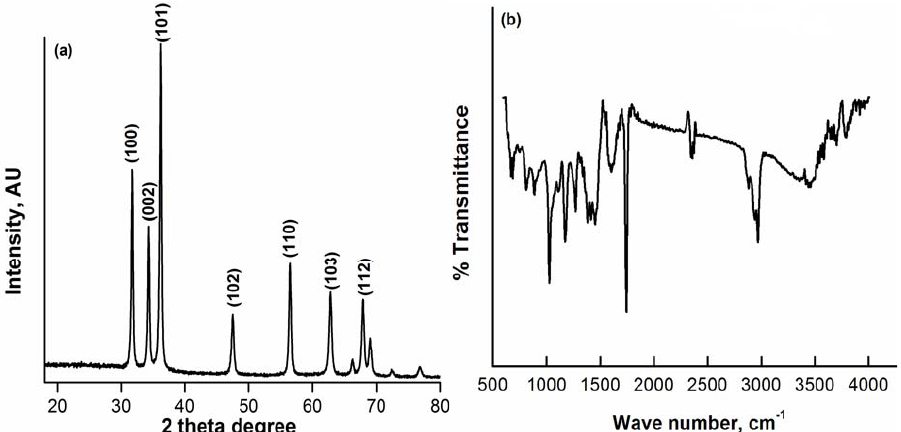
Fig. 1. (a) X- ray diffraction pattern, (b) FTIR spectrum of the synthesized ZnO nanoparticles